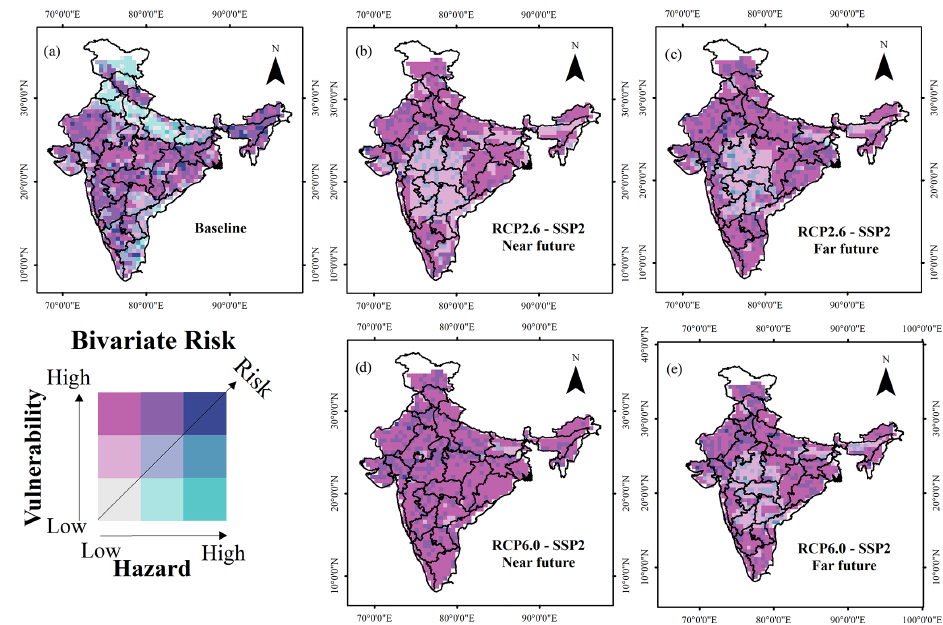
Figure 9. Bivariate choropleth drought risk maps showing hazard-driven and vulnerability-driven drought risk for the scenarios (a) baseline,